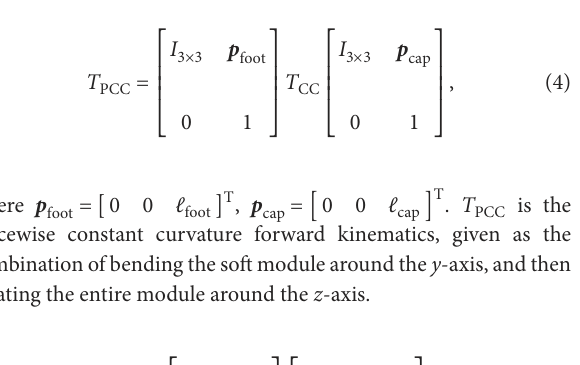
( Supplementary Material S1 ), and then each end of the cable sleeve is glued to the inner